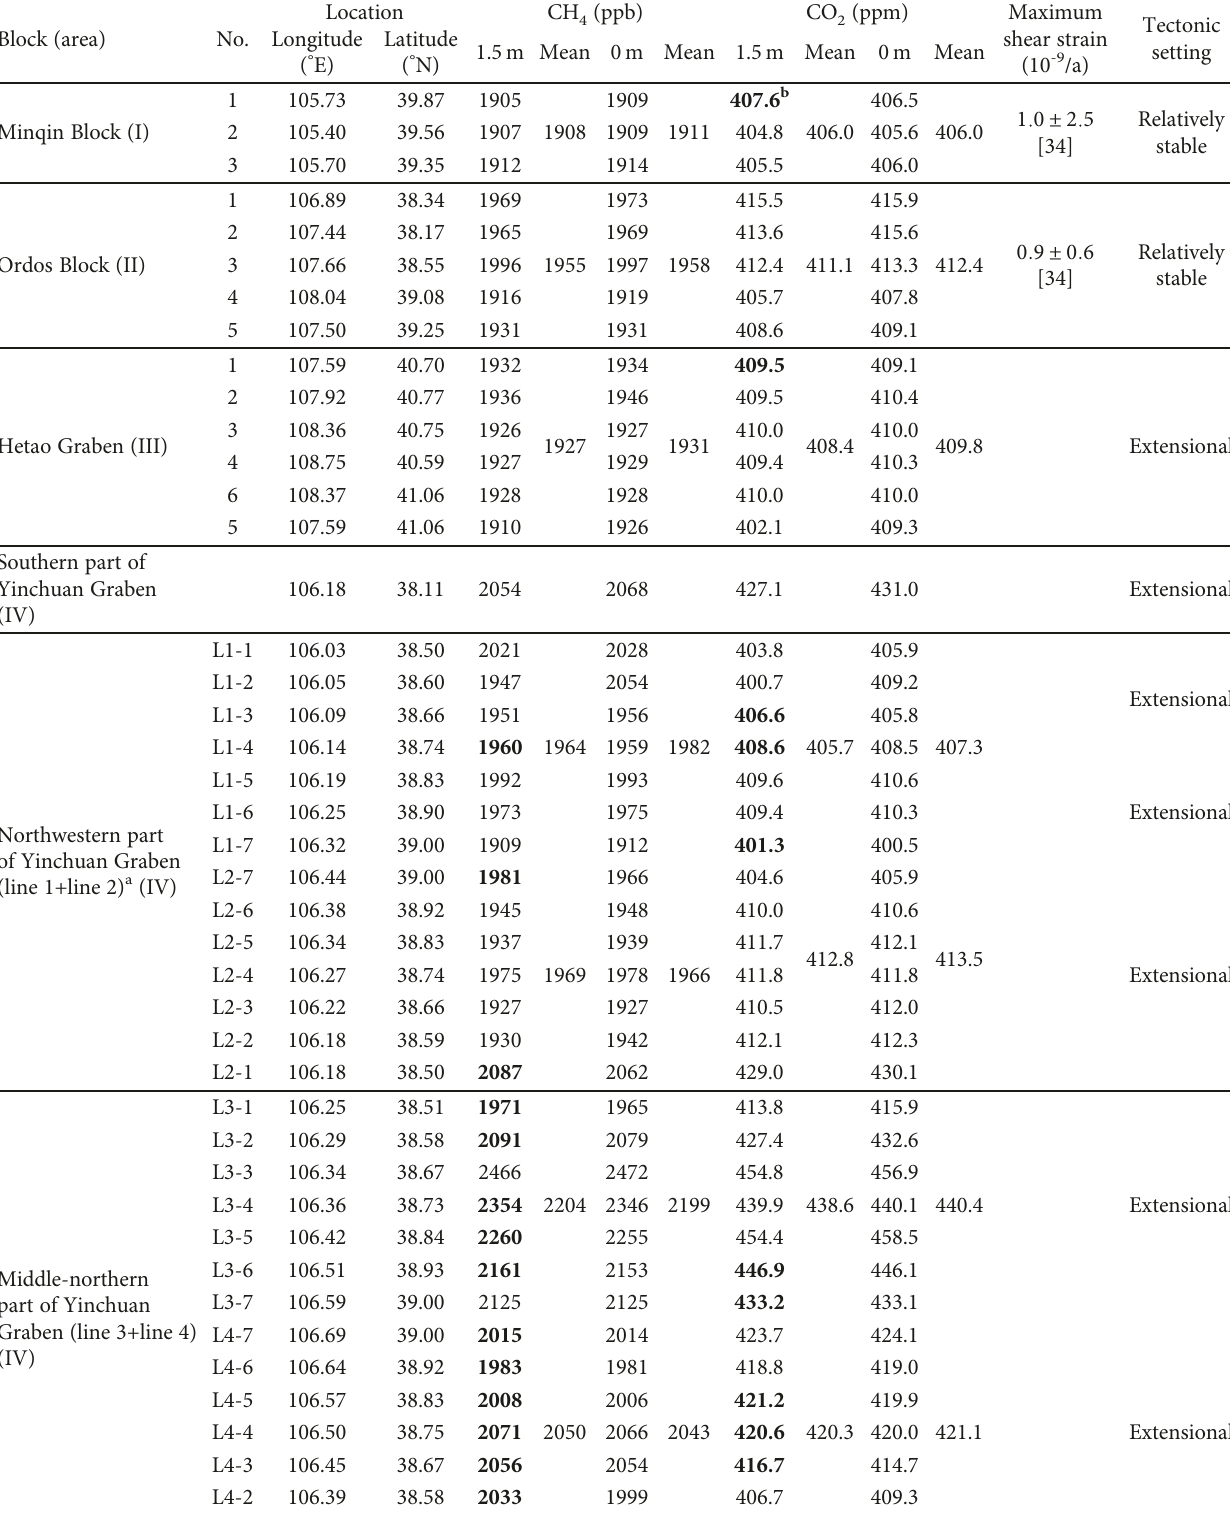
Table 1: CH and CO concentrations at the surface (0 m) and a height of 1.5m in di ff erent tectonic settings around the western margin of the 4 2 Ordos Block in